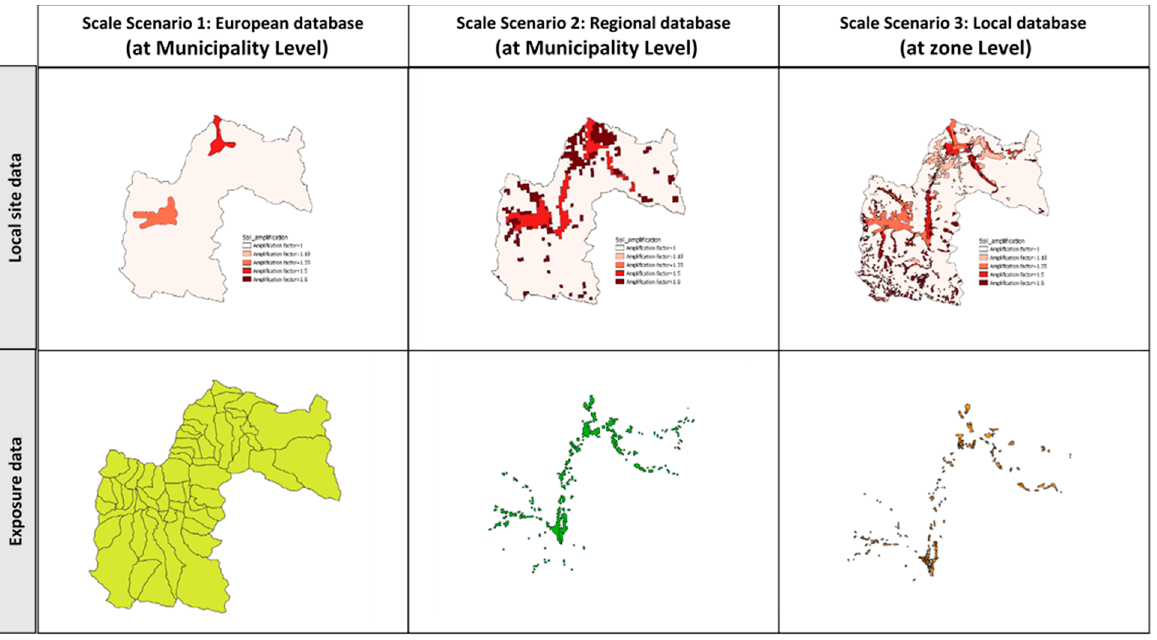
Figure 2. The site characterization maps and the building exposure used for the three scale scenarios defined in this study.